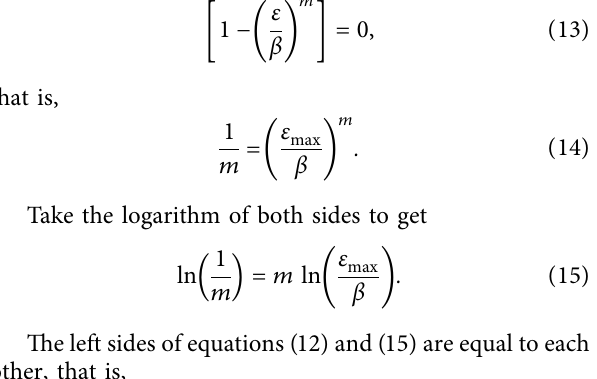
Figure 13: Relationship between strain rate and strength of samples with different freeze-thaw cycles under the axial pressure of 0MPa.